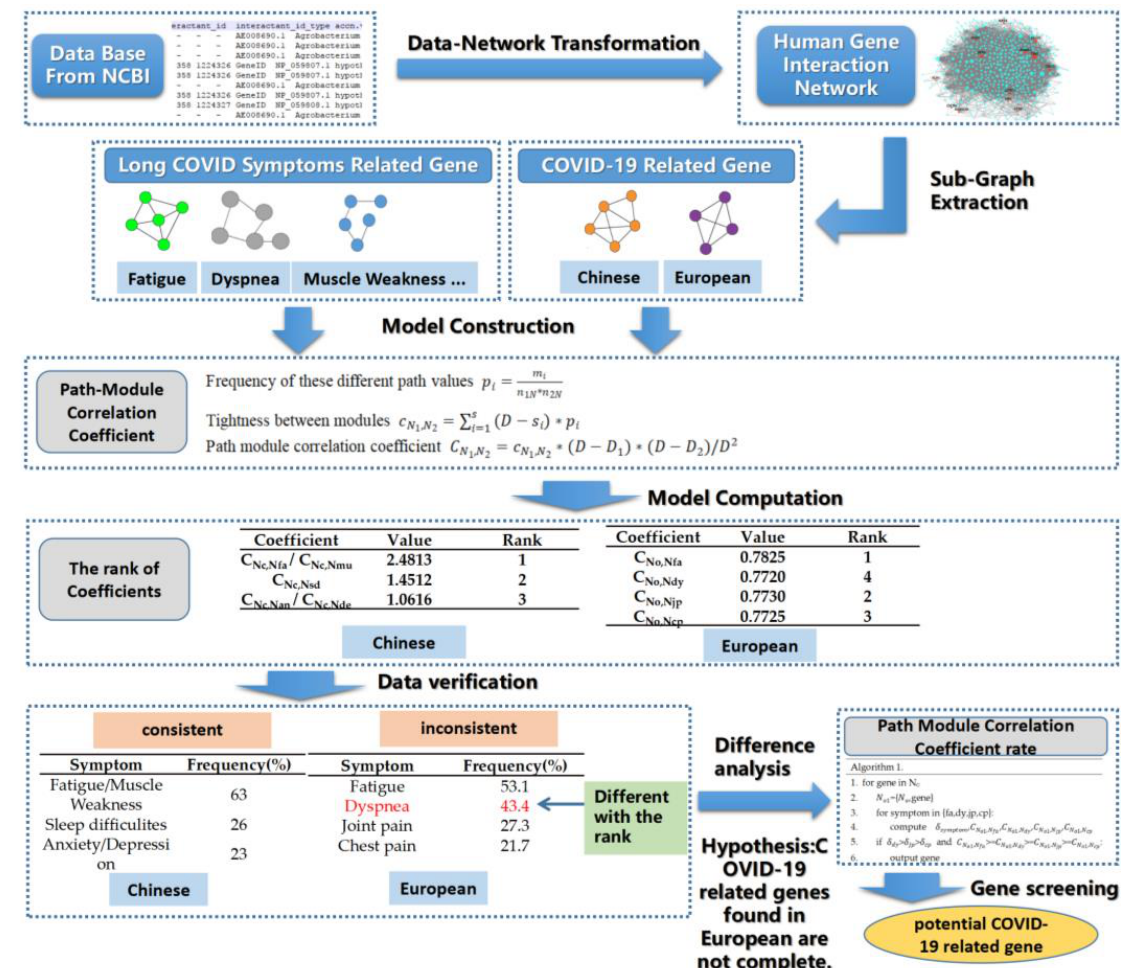
Figure 1. Graphical abstract of this work. The “ * ” means multiply in the figure.